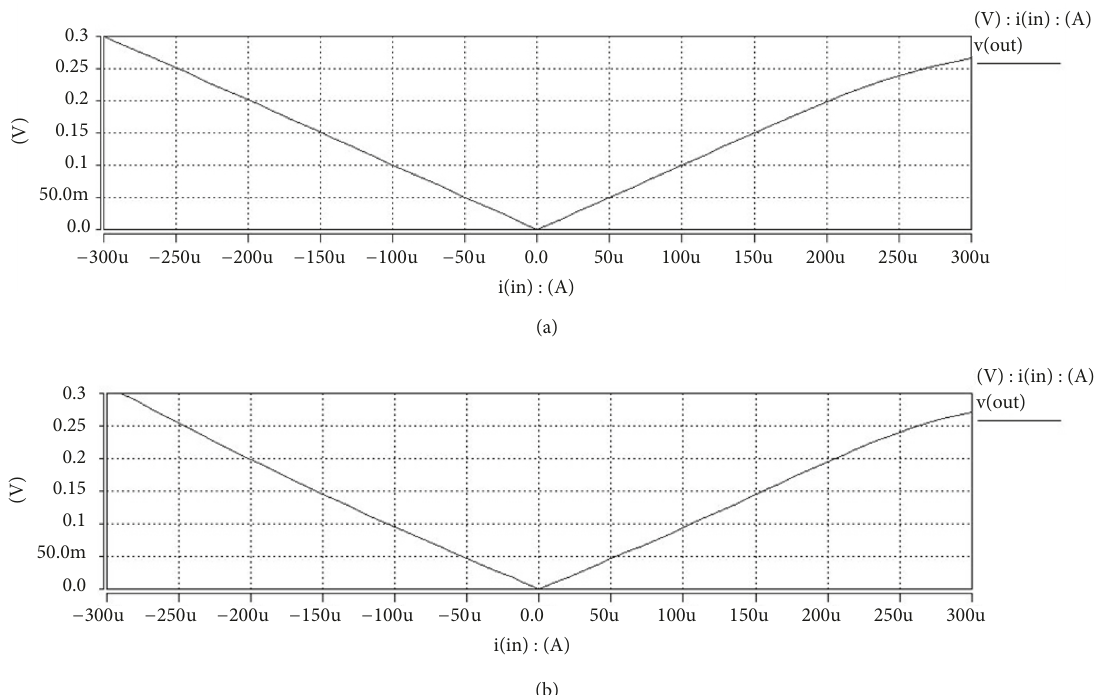
Figure 8: Simulation results of the input and output transfer characteristics in a wide scope of the (a) circuit in Figure 3 and (b) circuit in Figure